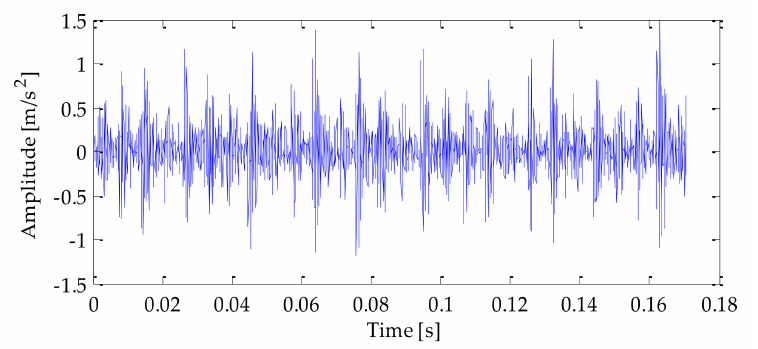
Figure 21. Time–domain analysis of the inner ring fault signal.